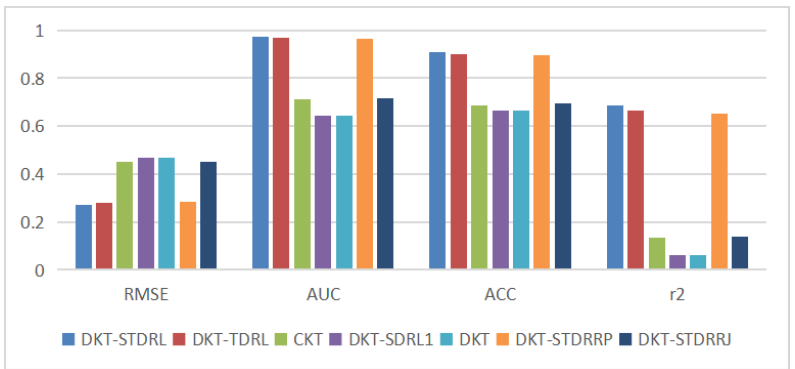
Figure 6. Prediction results of DKT-STDRL, CKT, DKT, and the variants of DKT-STDRL on the ASSISTchall